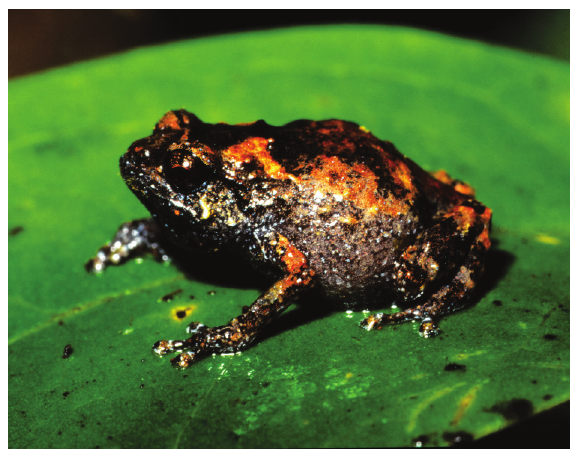
Figure 12. Paratype of Choerophryne bisyllaba sp. n. in life. Figure 13. Paratype of Choerophryne bisyllaba sp. n. in life.